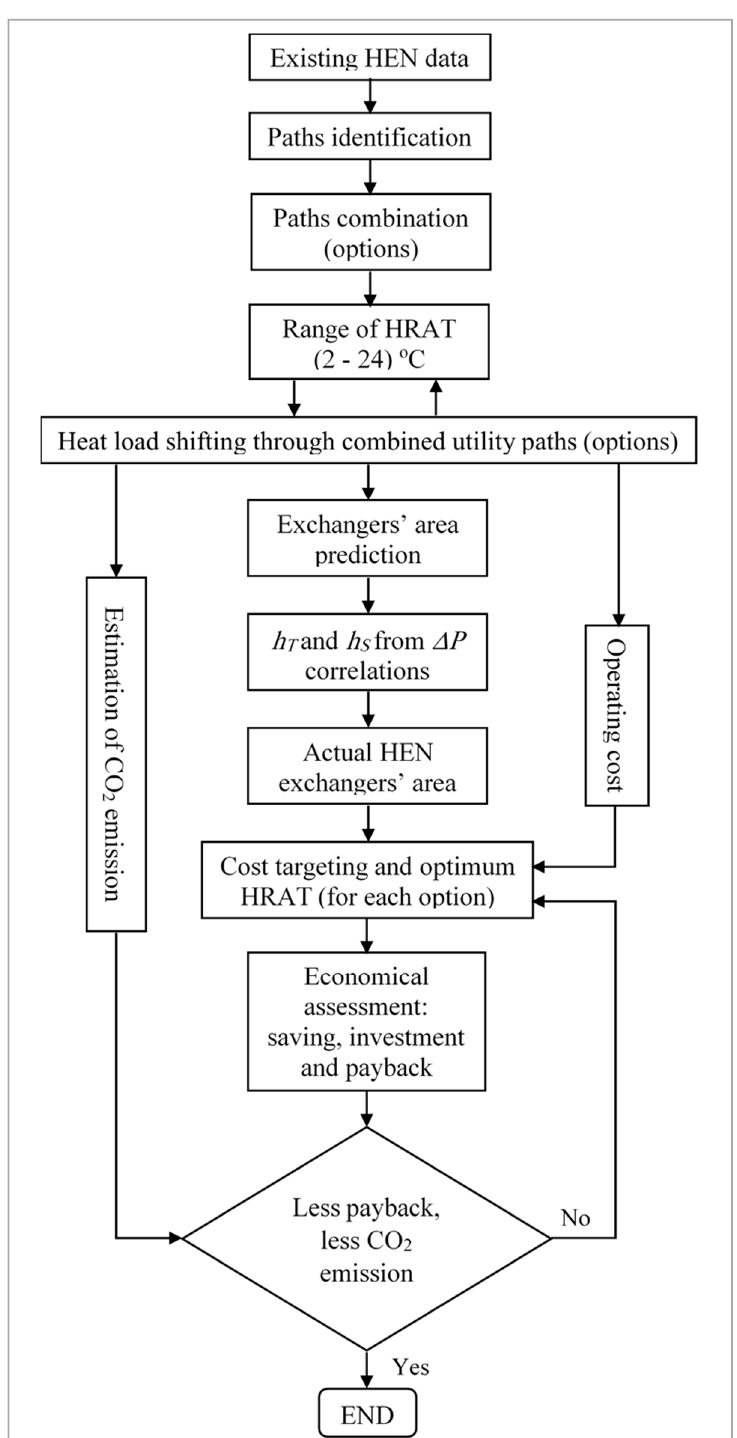
Figure 1. Overall methodology flow diagram.